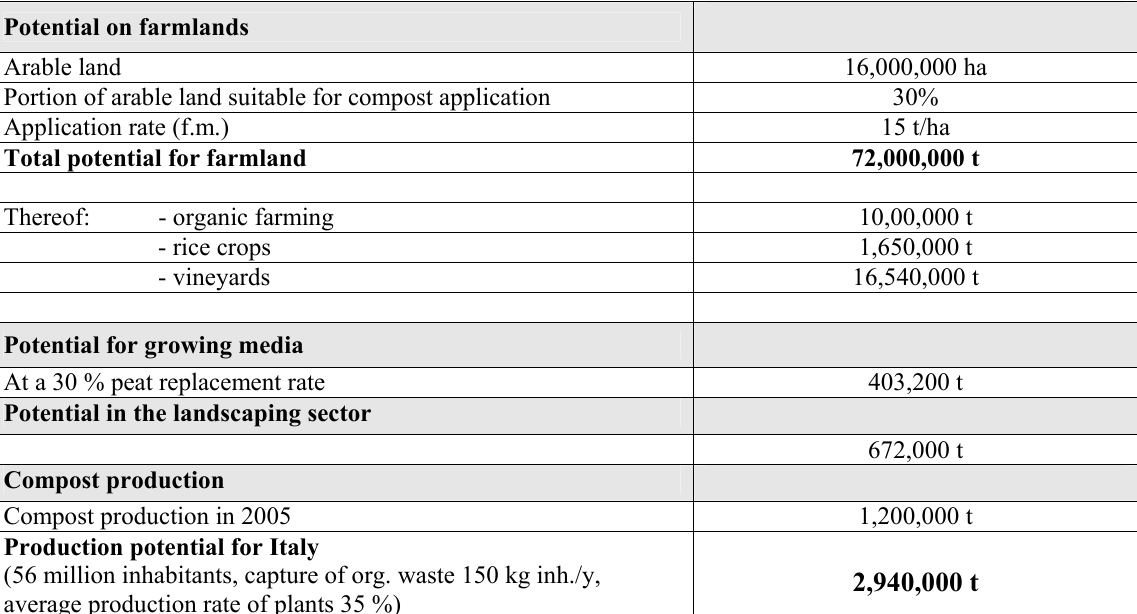
Table 46: Compost market potential on Italy (Favonio, 2007) [b30] Potential on farmlands Arable land Portion of arable land suitable for compost